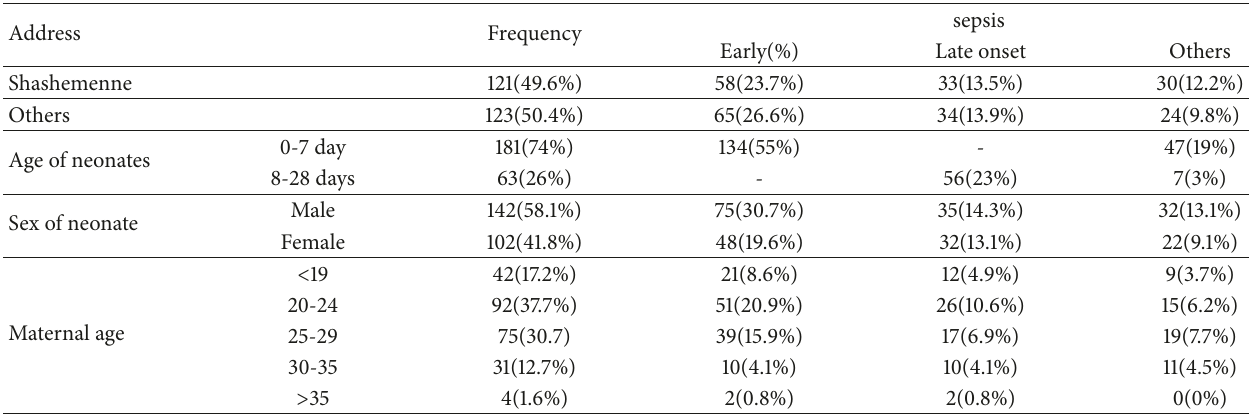
Table 1: Sociodemographic characteristics of neonates and mothers unit at selected governmental hospital in Shashemene town, Oromia regional state, south ethiopia, 2017G.